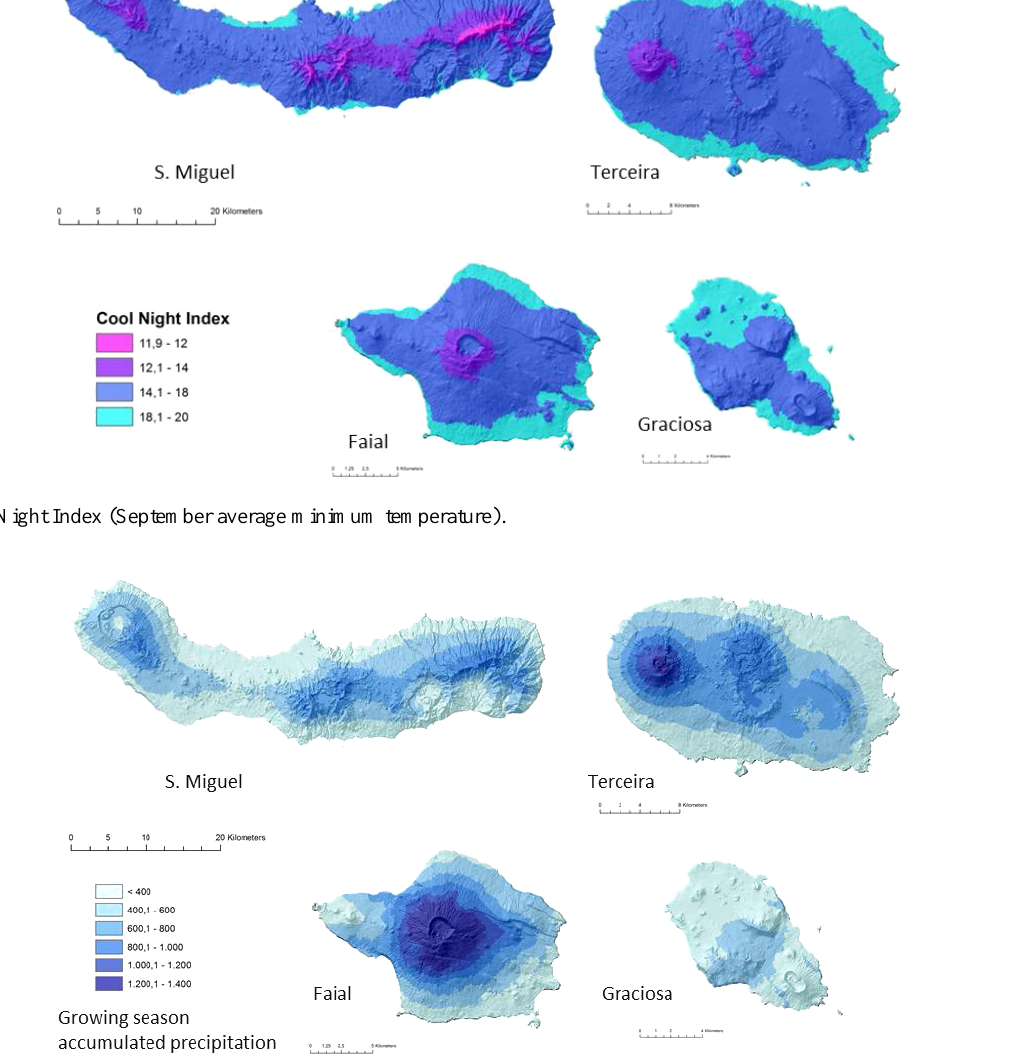
Figure 7. Growing season accumulated precipitation in millimeters